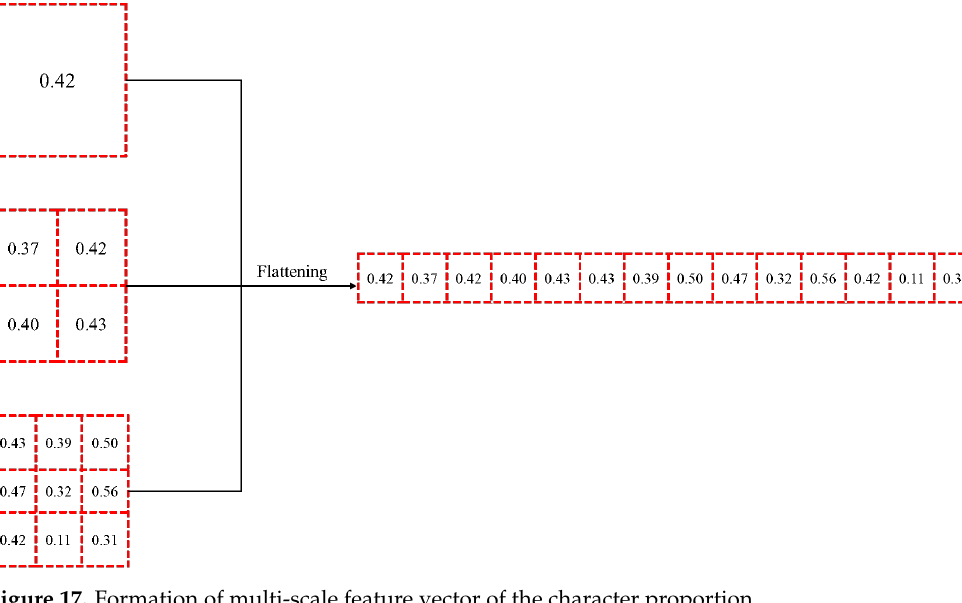
Figure 17. Formation of multi-scale feature vector of the character